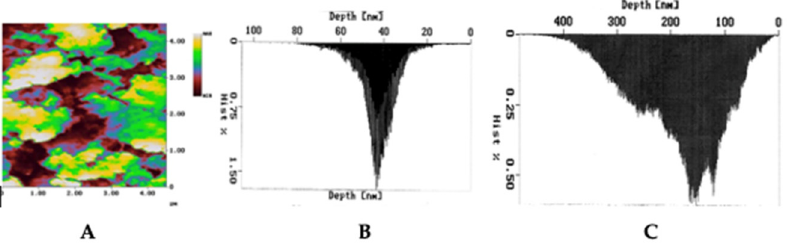
Figure 3. Formation of micropores in the rabbit cartilage plate under laser action studied by Atomic Force Microscopy: ( A ) image of micropores; size distribution of micropores ( B ) before and ( C ) after laser exposure.